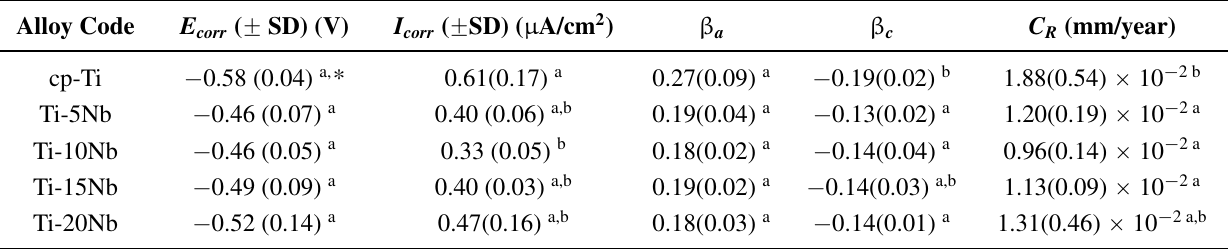
Table 3. Corrosion potential ( E alloys ( n = 3).